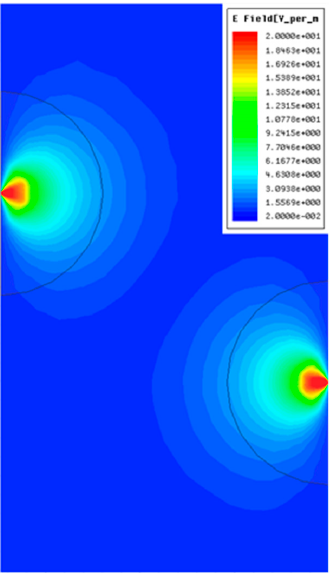
Figure 5. Magnitude of the electrical field, E , at plane z = 0 of the analysis domain when max_1 and λ = 500 nm are considered. The two semicircles represent the top view of the silver nanoparticles in the analysis